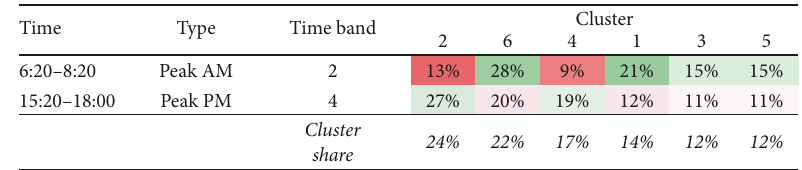
Figure 9: Northbound ØD trains. Cluster share by time band. The color code compares the individual row’s distributions among clusters to the overall distribution among clusters reported in the last row. Clusters sorted by